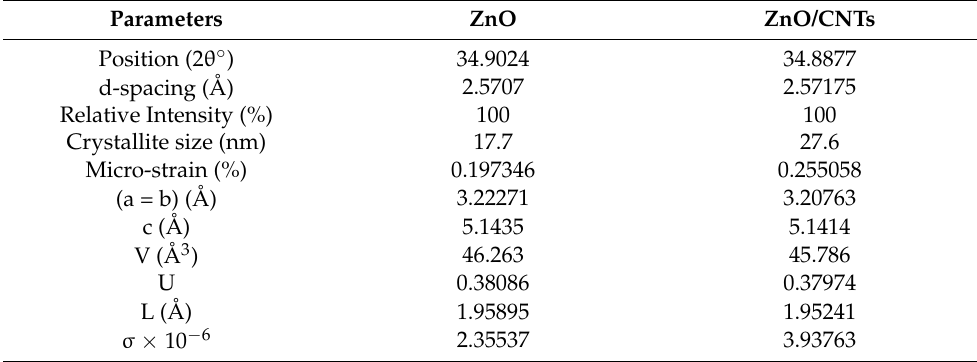
Table 1. The XRD parameters for the ZnO and ZnO/CNTs thin films for the (002) plane.